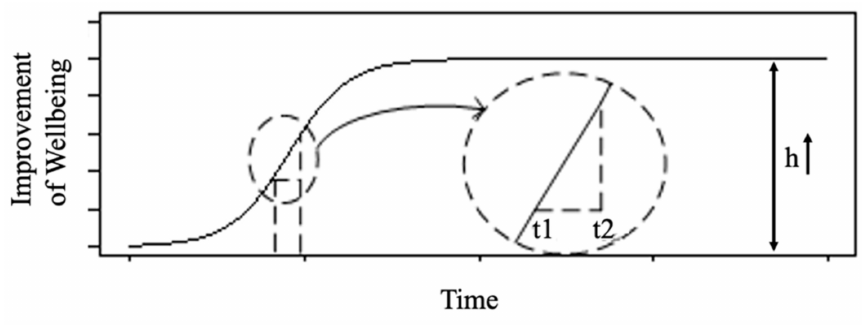
Figure 5. Longitudinal benefits to occupant